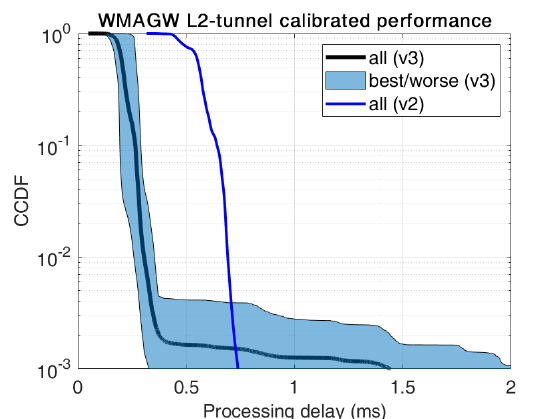
Figure 7. CCDF of the total processing delay experienced in L2-tunneling operational conditions (with two WMAGW